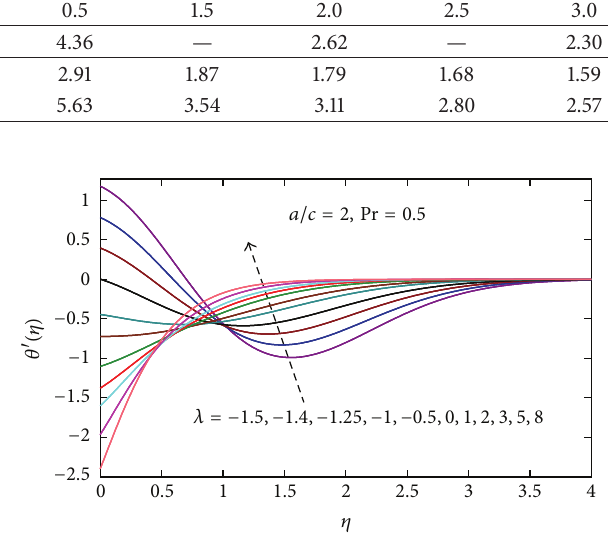
Figure 5: Temperature profiles 𝜃(𝜂) for various values of 𝜆 with 𝑎/𝑐 = 2 .